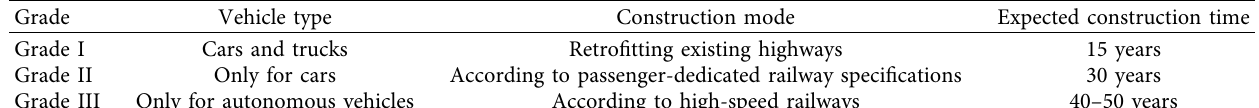
Table 3: Comparison of the different superhighway grades.